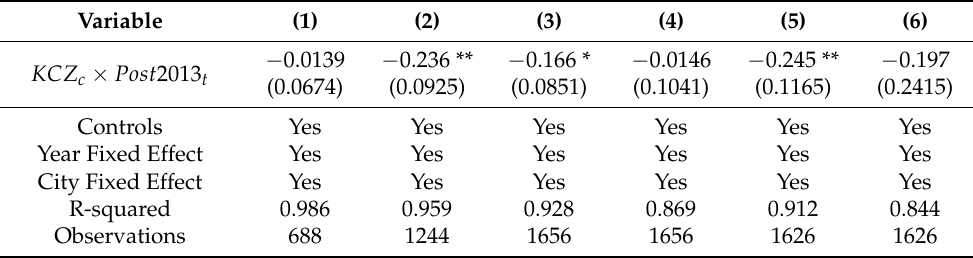
Table 6. Heterogeneity